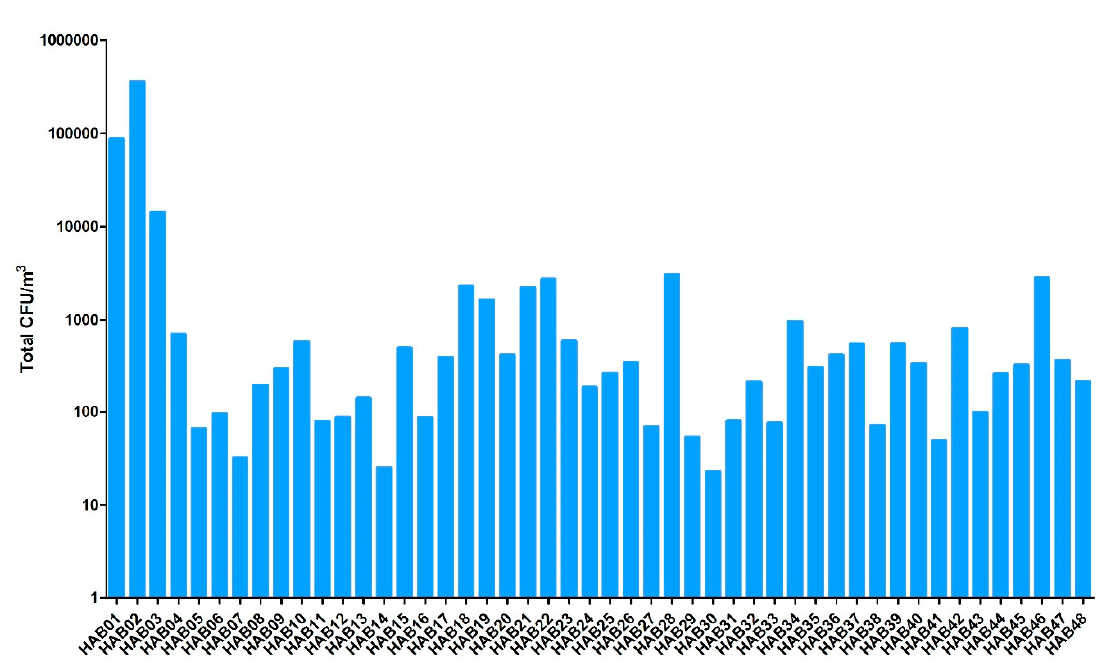
Table 3. Molds identified from bioaerosols in mold-damaged homes (n = 48) at a frequency above 10%.